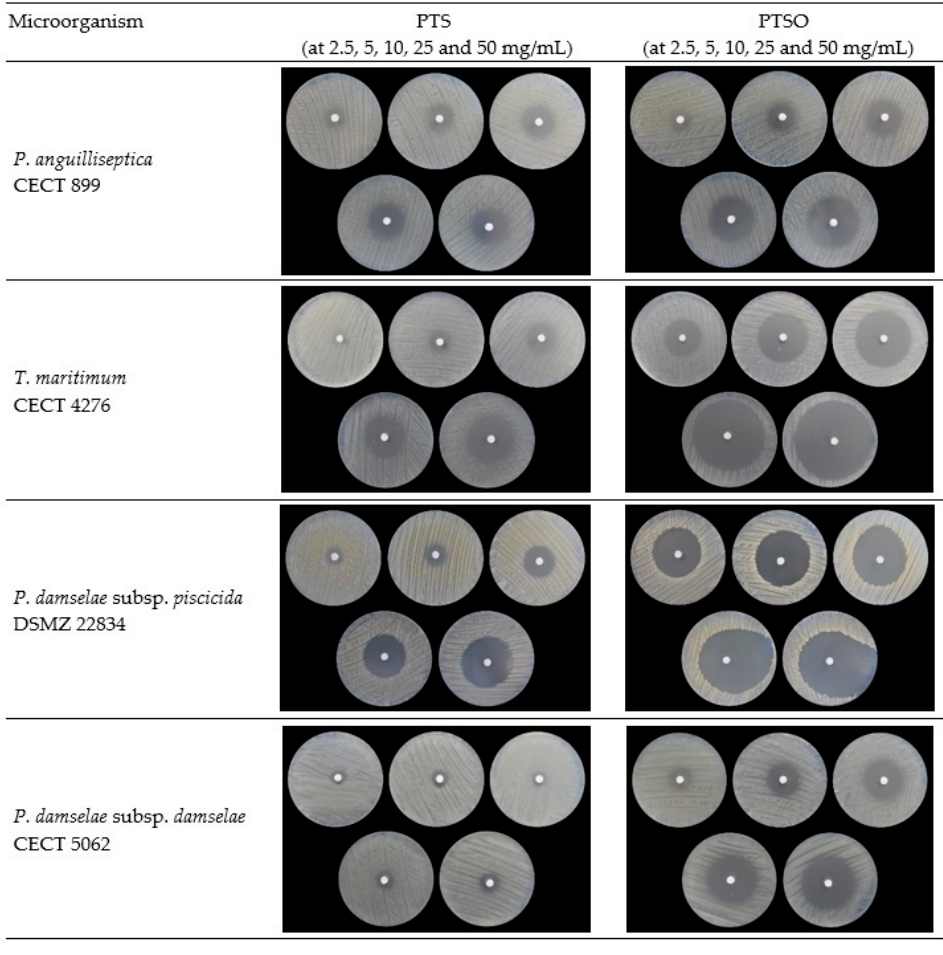
Figure 2. Results of the antibiosis test in solid media of PTS and PTSO at different concentrations against the target strains.